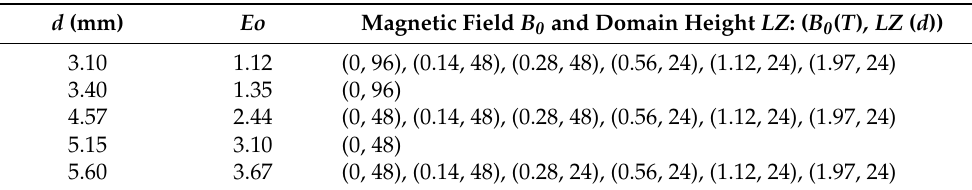
Table 5. List of validation cases: Mo = 2.38 × 10 − 13 for all